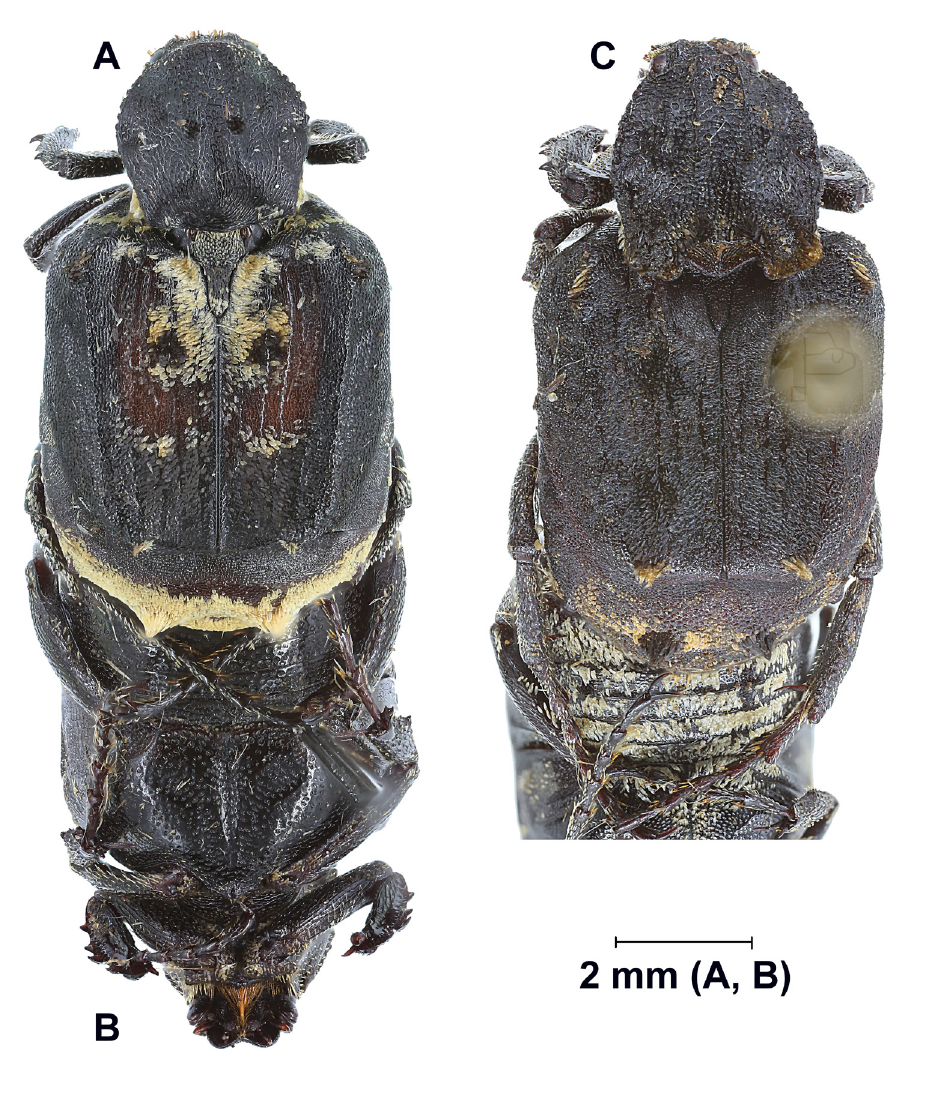
Fig. 2. Mating pair of Hybovalgus tonkinensis Moser, 1904, from Fujian (IZAS). A . ♂. B– C .